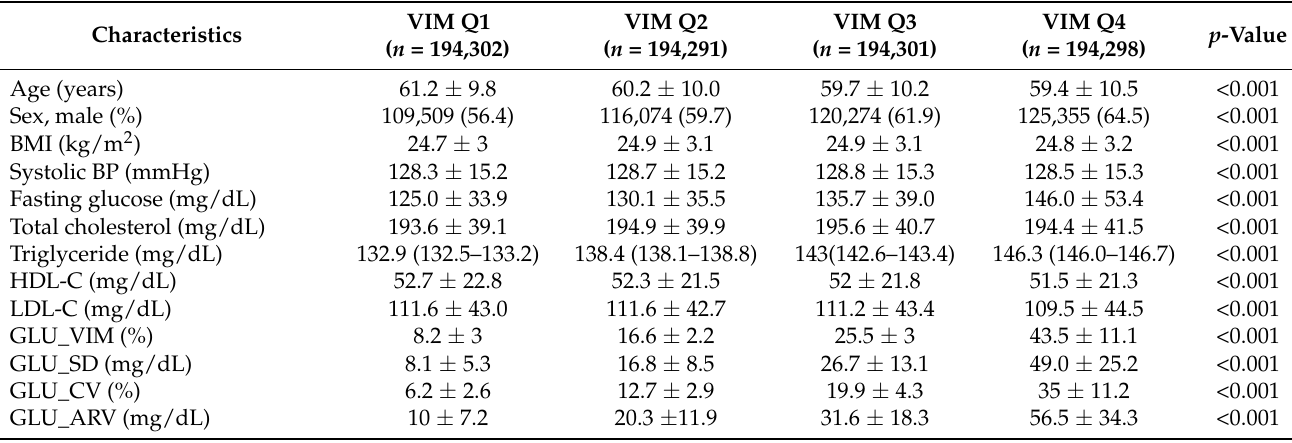
Table 1. Baseline characteristics of the study subjects according to quartiles of fasting glucose variability a .